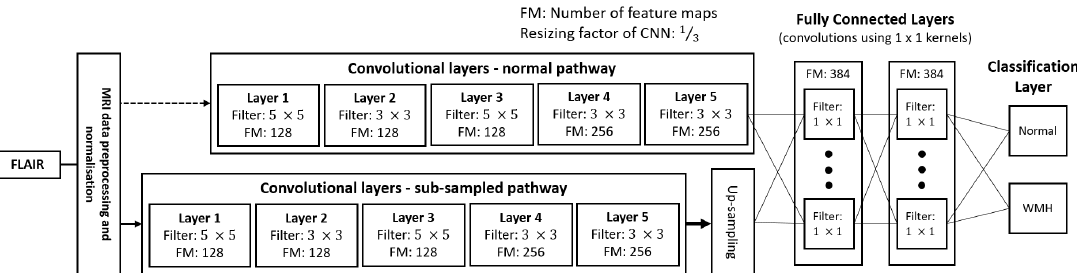
Figure 3. Architecture patch-wise convolutional neural network (patch-CNN) used in this study which is created using DeepMedic. See DeepMedic’s paper [7] for full explanation of the architecture. Table 3. Parameters of patch-wise convolutional neural network (adopted from